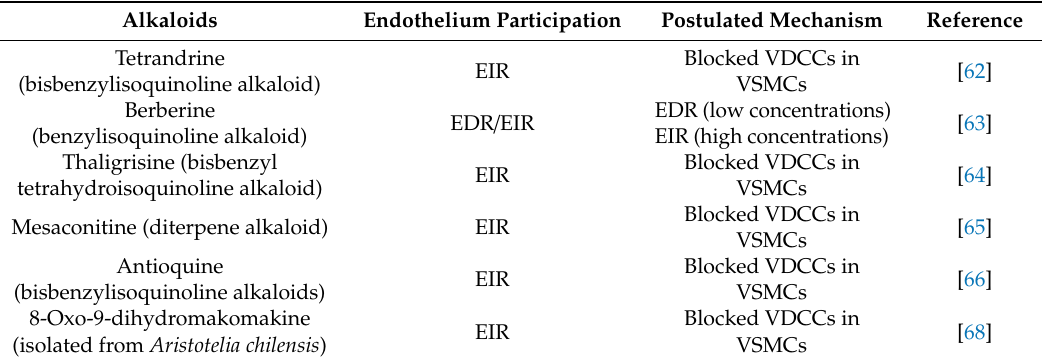
Table 2. Summary of vasodilator e ff ects induced by alkaloids in isolated rat aorta (IRA).